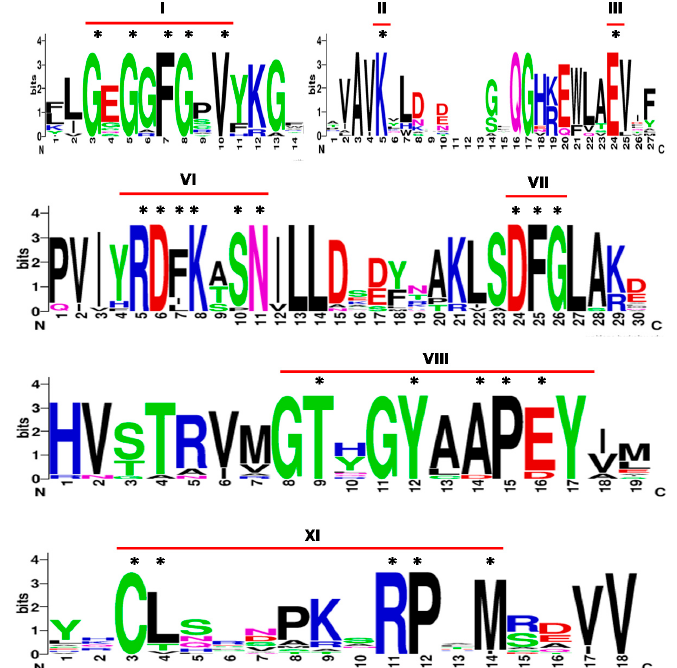
Figure 1. Sequence logo of conserved motifs in protein tyrosine kinases of rice. The sequence logos are based on multiple alignment analysis of 18 rice PTK proteins. The bit score indicates the residue content for each position in the sequence. * conserved residues in each sub-domain. Roman numbers I-XI denote sub-domains in kinase domain.